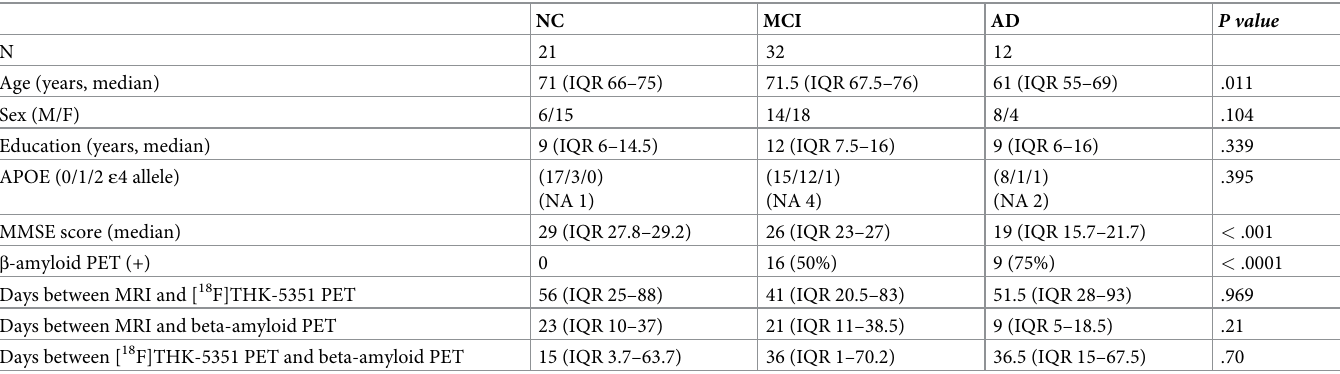
Table 1. Demographics of the study